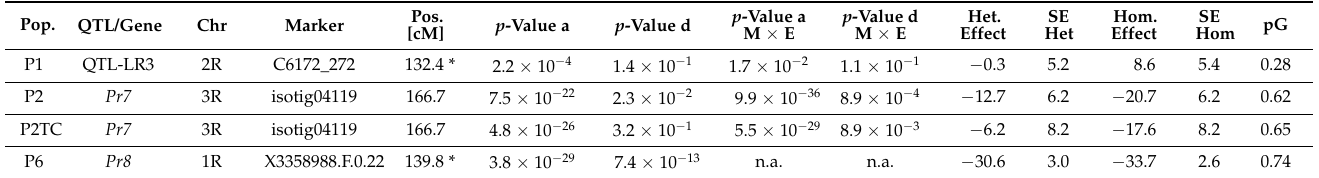
Figure 10. LOD ( − log 10 ( p -value)) profiles for populations P1–P3, P6 and P2TC for leaf rust. p -values of the single markers were calculated from a mixed linear model fitting main marker-effects (red) and marker-environment effects (blue) sequentially as fixed effects. Marker order of P2–P5 and P2TC was based on a consensus map from linkage maps of all populations (and populations from previous projects). Marker order of P6 was calculated separately as a different marker system was used. The dashed line shows the global significance threshold (alpha = 0.05) adjusted for multiple testing by the simpleM method. Mapping in P6 was based on data from a single location only. Table 9. QTL/Gene effects for the naturally occurring leaf rust associated with respective markers in the different